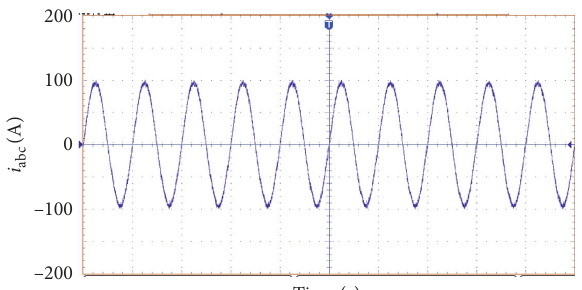
Figure 17: Experimental current waveform of the ESS (output power is set to